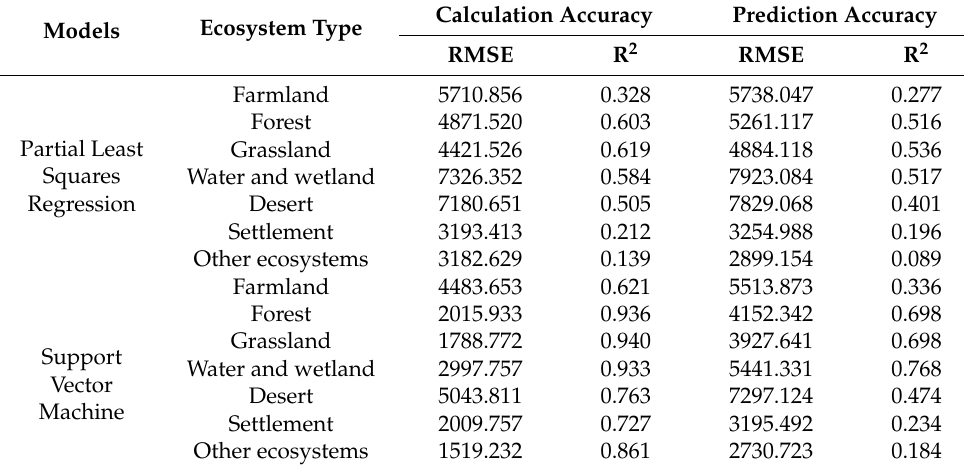
Table 4. Accuracy assessment for the stratified prediction